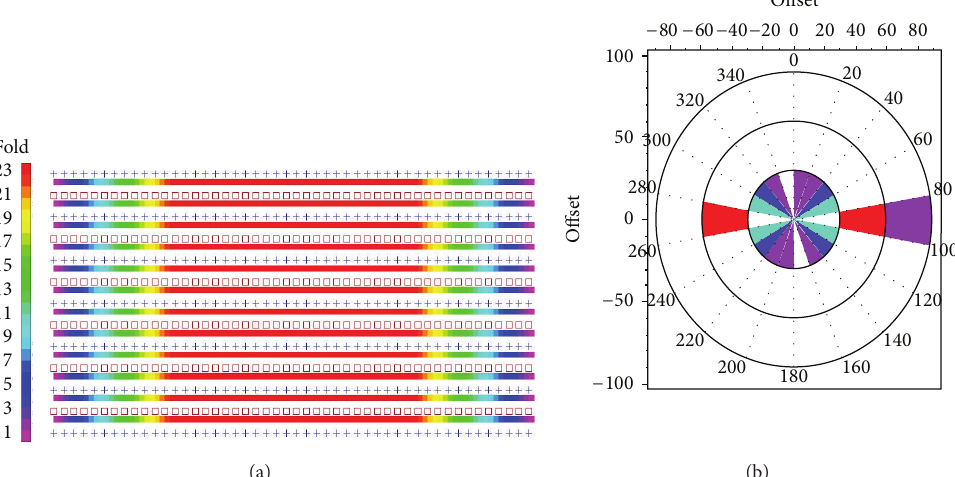
Figure 6: Fold scheme. (a) The shots locations are marked by “+” and receivers locations are marked by squares, (b) fold as function of azimuth.